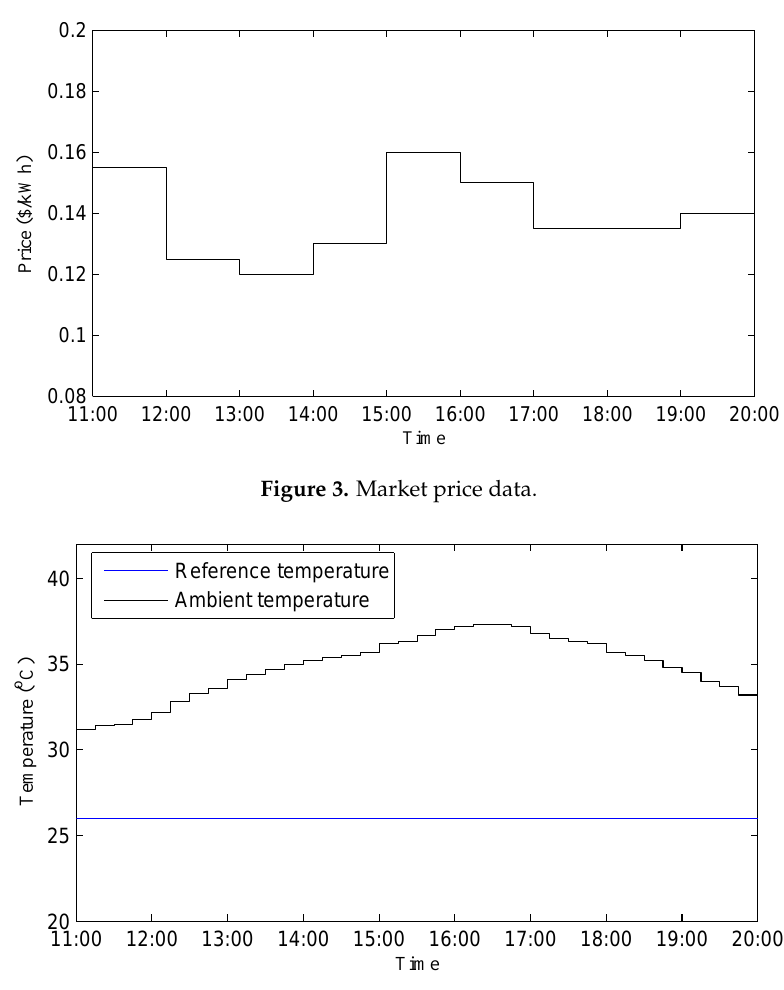
Figure 4. Ambient temperature and Reference temperature from 11:00 to 20:00 on a summer day.